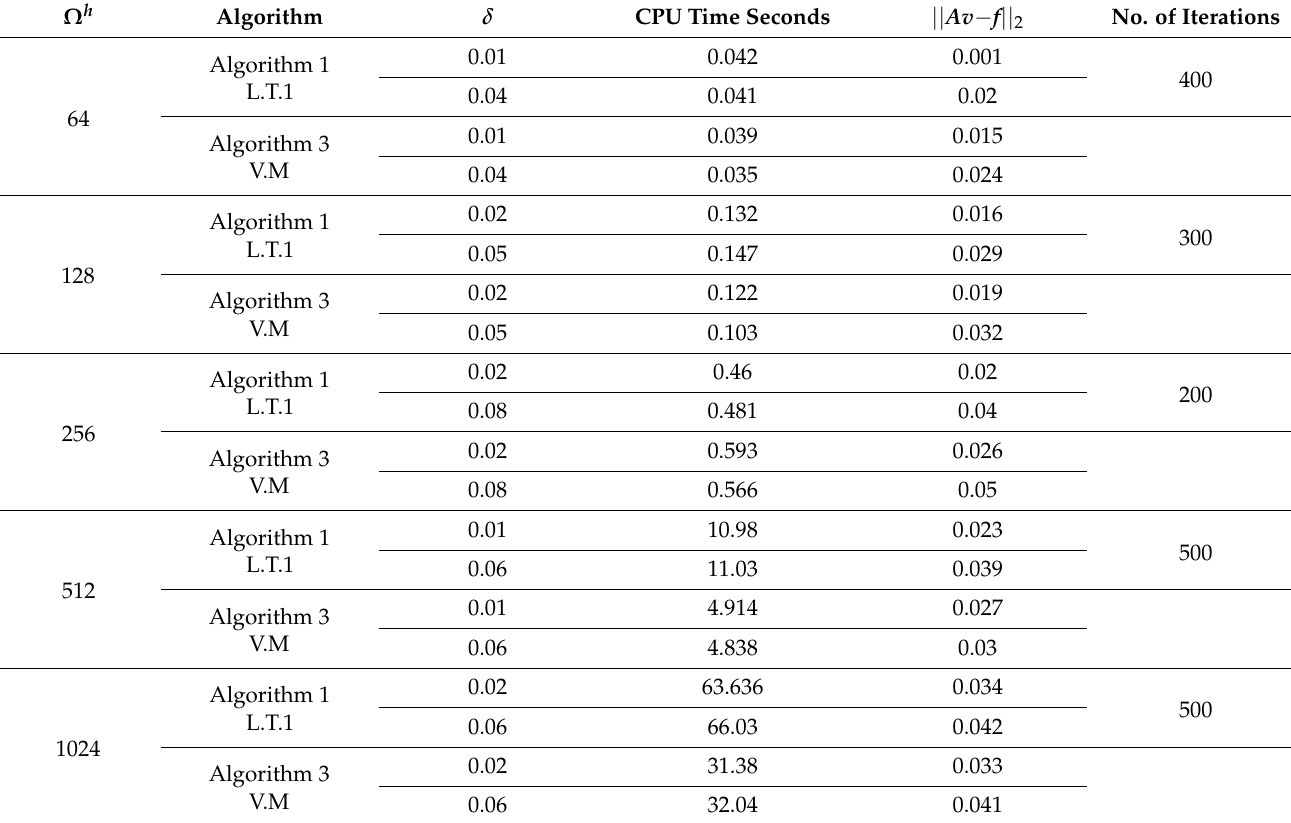
Table 1. Results for boundary value problem in different Ω h